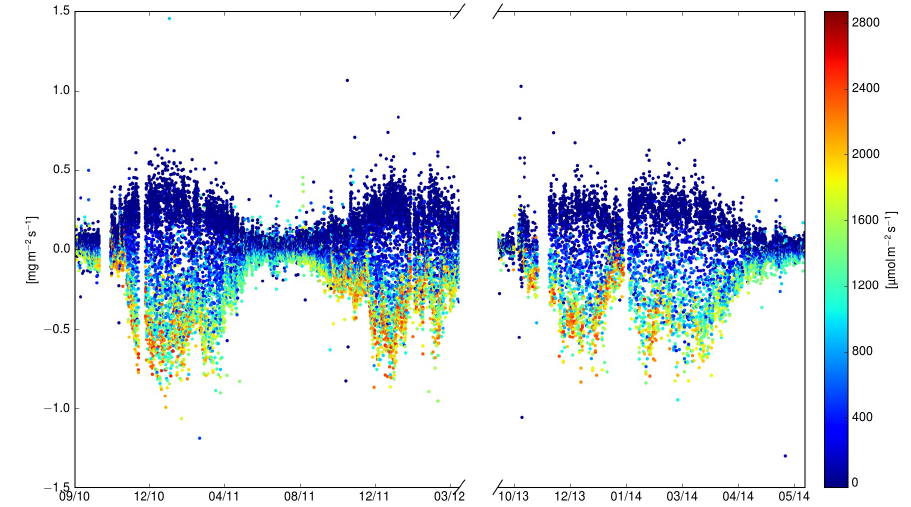
Figure 4. Micrometeorological CO 2 flux measurements at Welgegund (Räsänen et al., 2016). The colour bar indicates the photosynthetic photon flux density (PPFD).